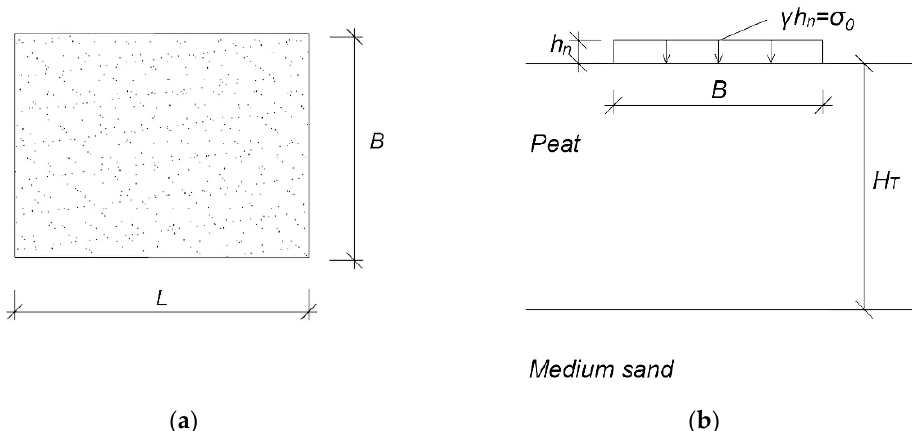
Figure 2. Scheme of the embankment: ( a ) top view; ( b ) cross-section. B , embankment width (m); L , embankment length (m); h n , height of the embankment (m); γ , weight of the embankment (kN m − 3 ); σ 0 , loaded with the embankment (kPa); H T , thickness of organic soil (m).